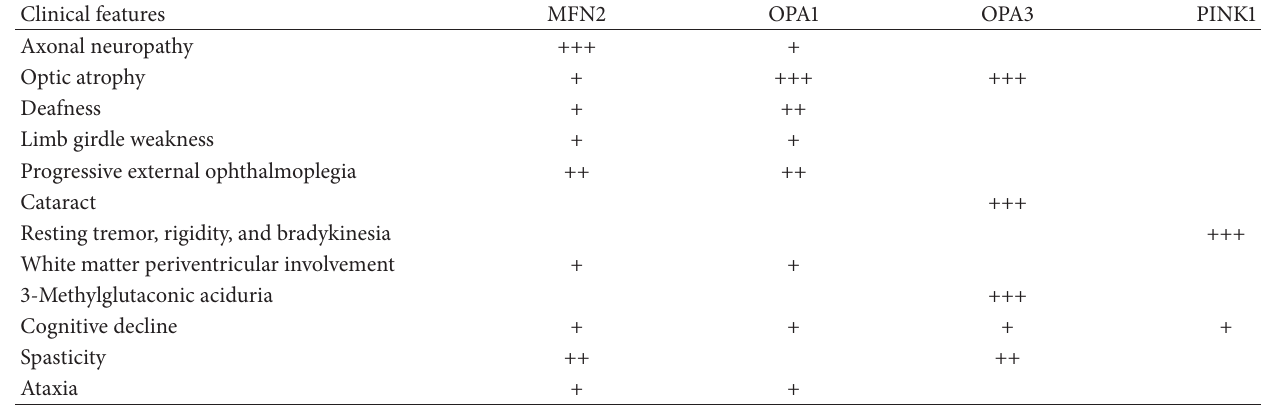
Table 1: Clinical features and their prevalence according to